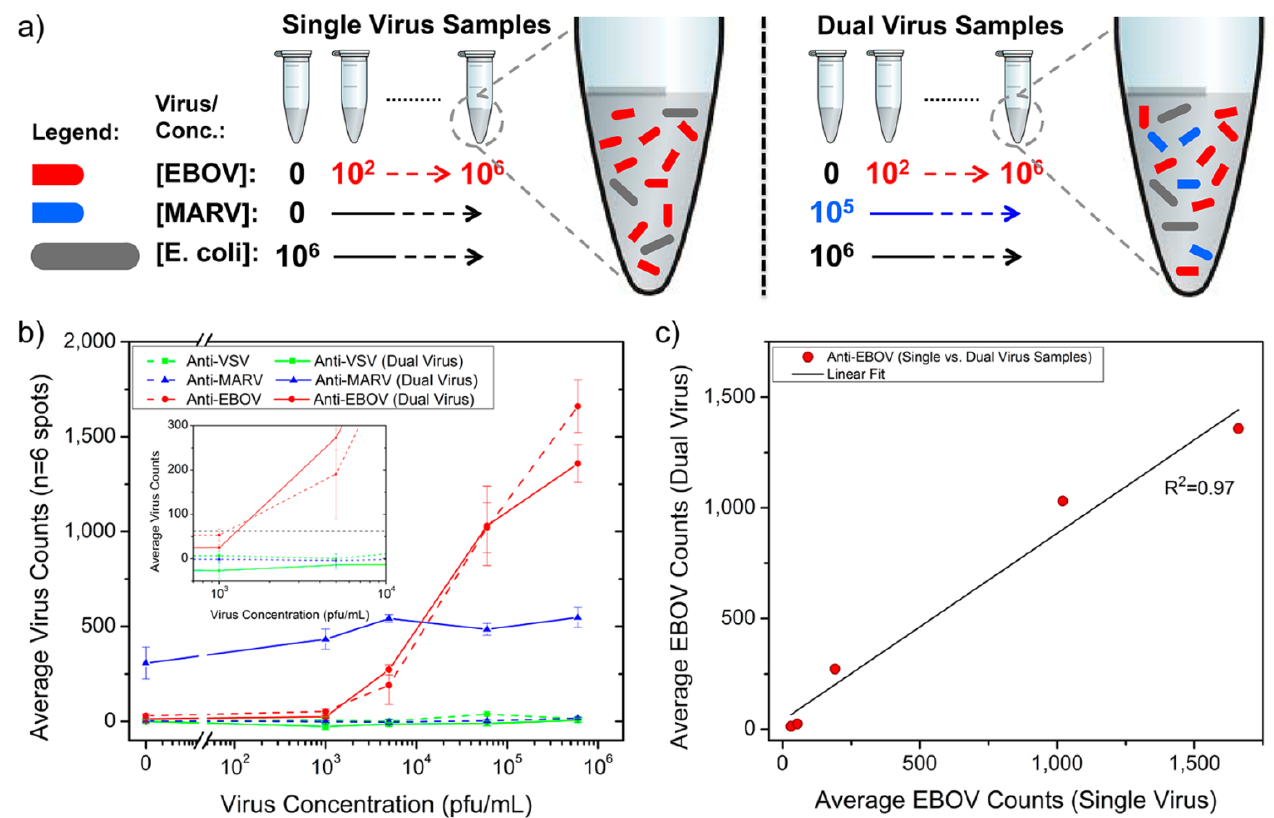
Figure 3. Dual detection of pseudotyped EBOV and MARV from fetal bovine serum contaminated with E. coli K12 at the concentration of 10 6 CFU/mL. Scheme of ( a ) preparation of single and dual virus spiked samples; ( b ) the results obtained for single virus detection and dual detection at different virus concentrations; ( c ) the response obtained with anti-Ebola spots for FBS and bacteria spiked FBS samples was similar, as indicated by the linear regression fitting the scatter plot of one sample type versus the other [39]. Reproduced with permission from G.G. Daaboul, C.A. Lopez, J. Chinnala, B.B.